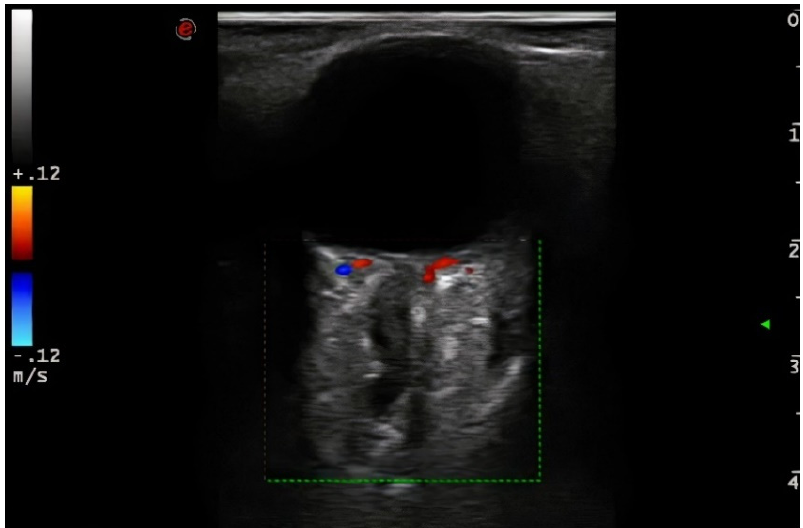
Figure 1. The absence of color and pulsed Doppler signal in the peripapillary portion of the CRA (diagnosis of CRAO). 3-9 MHz linear probe (Esaote MyLab70 and My Lab9, Esaote, Milan).